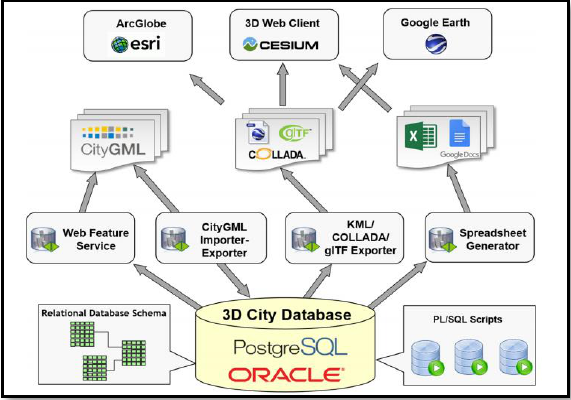
Figure 6. The components of 3DcityDB software (Yao et al., 2018)